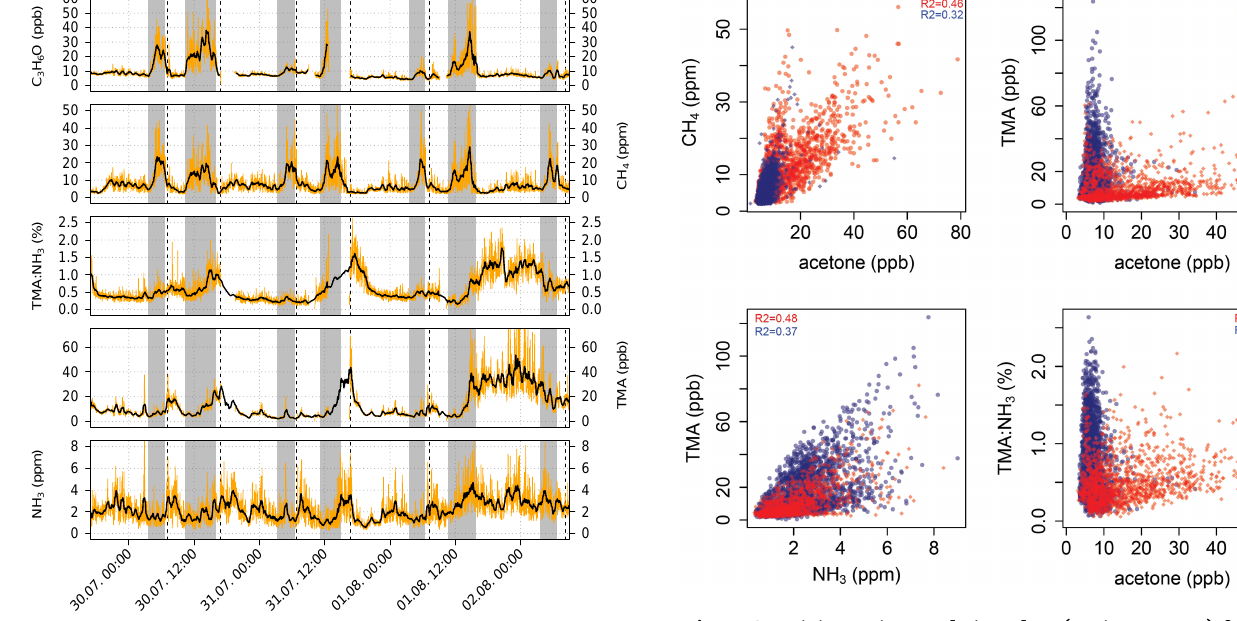
Figure 3. Mixing ratio correlation plots (1min averages) for the period 29 July 17:00 to 2 August 9:00 (also shown in Fig. 2) of (a) CH 4 vs. acetone, (b) TMA vs. acetone, (c) TMA vs. NH 3 , (d) TMA : NH 3 vs. acetone; red circles are the measurements dur- ing presence of cows, blue diamonds are in absence of